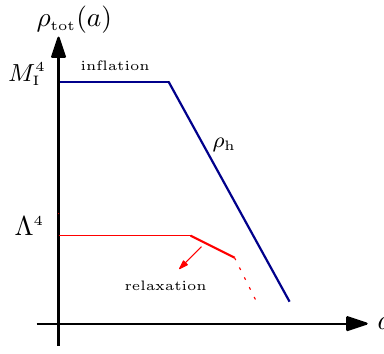
Figure 36 . Sketch of the energy density of the universe as a function of the scale factor in the case where relaxation takes place after in(cid:13)ation and when the energy density of the universe is dominated by a hidden sector that later decays into the